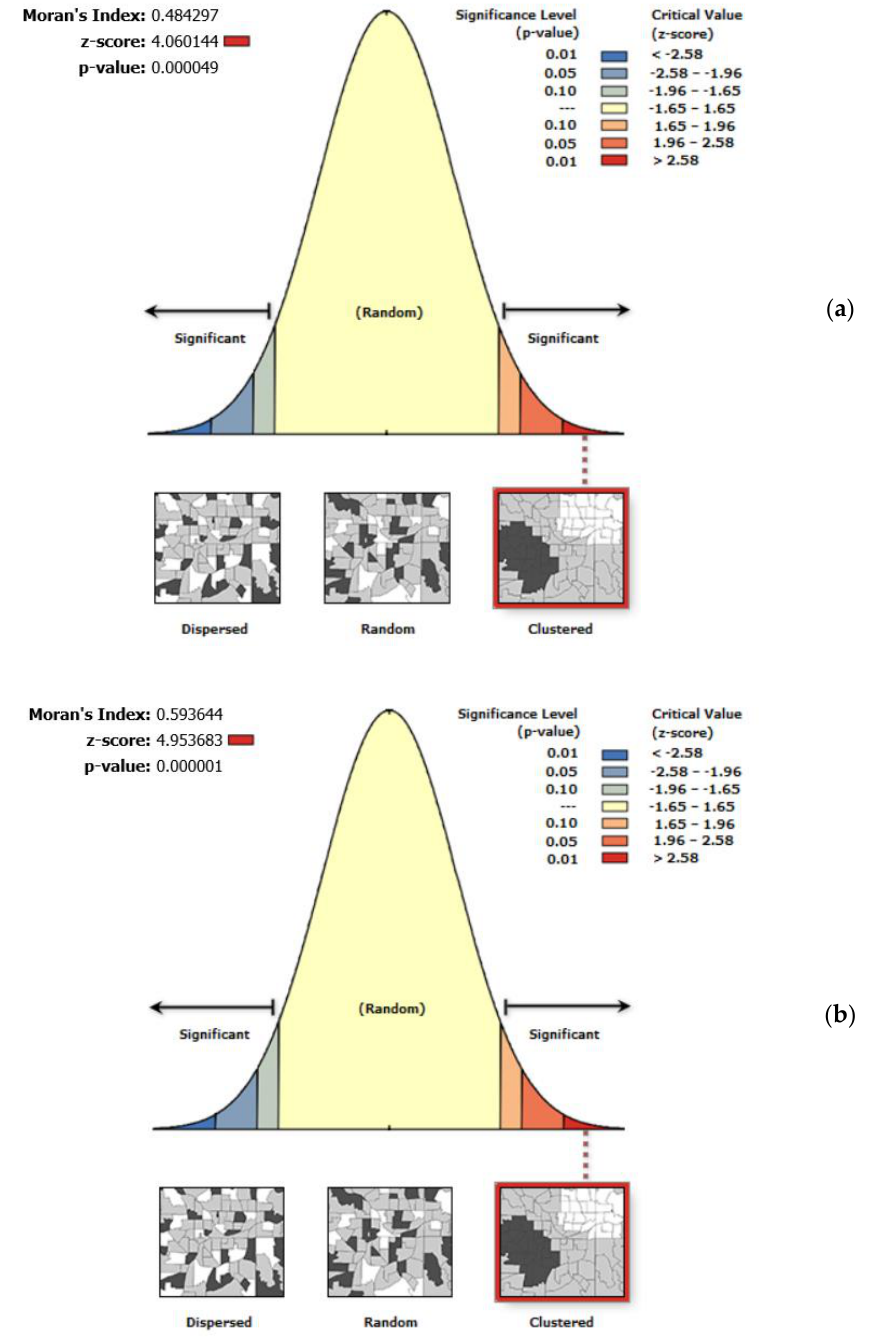
Figure 8. Moran’s I index and Z values of lung cancer incidence in Guangzhou: ( a ) 2015; ( b ) 2013.